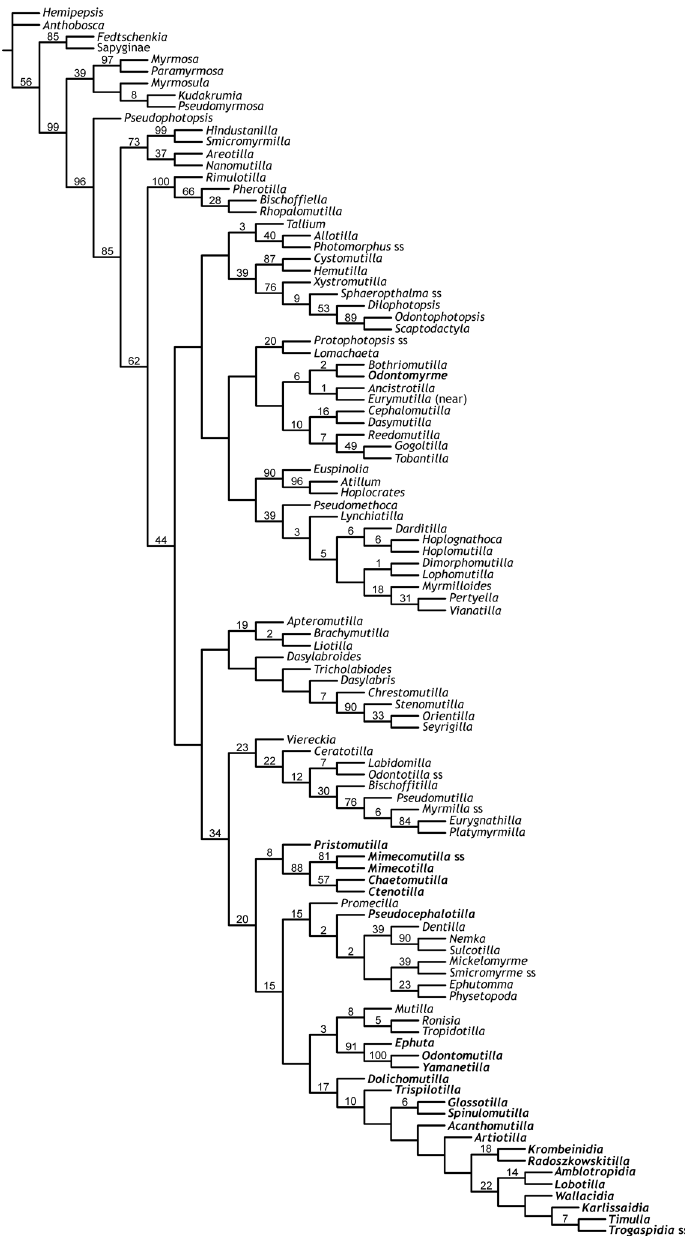
Figure 13. Tree based on preferred tree (see Fig. 5) but with branches re-arranged to make the potential recognizable groups (see Fig. 12) monophyletic (length = 2858, ci = 0.19, ri = 0.60). Group support (GC) values shown for all groups supported by resampling; the highest values obtained when resampling all non-additive or mostly additive characters, using equal weights and implied weights (N = 5), are shown. Terminals in bold are those whose placements differ by more than mere taxonomic level in the classifica- tions of DB and LN (see Appendix